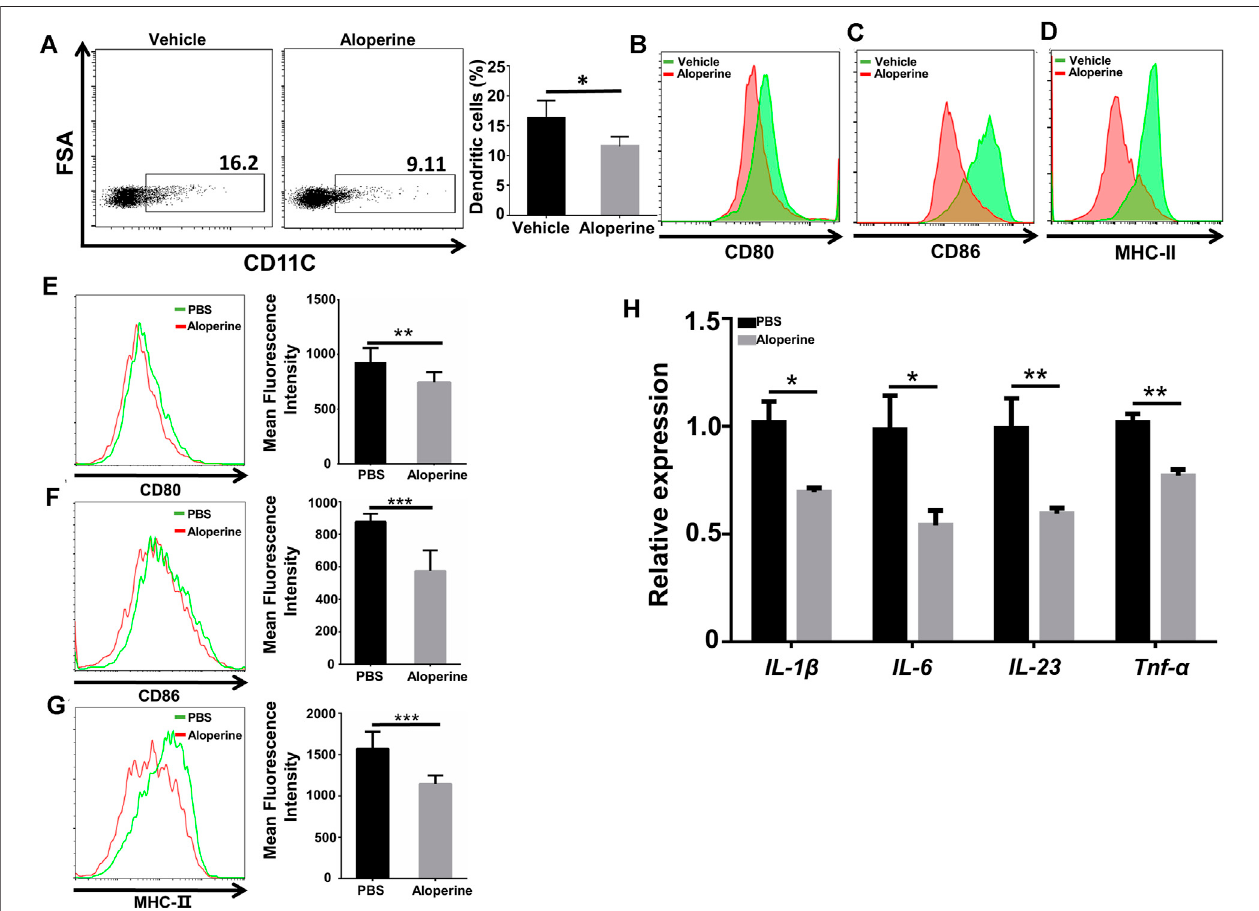
FIGURE 2 | Aloperine inhibits the activation of DCs. (A) The proportion of CD11C + DCs among CD45 + cells in the skin lesion. (B – D) Mean Fluorescence Intensity (MFI) analysis of the expression of CD80, CD86, and MHC- Ⅱ on skin DCs. (E – G) MFI analysis of the expression of CD80, CD86, and MHC- Ⅱ in in vitro differentiated BMDCs. (H) Real-time PCR analysis of cytokine expression (IL-1 β , IL-6, IL-23, and TNF- α ) in DCs. The data are shown as the mean ± SEM from three independent experiments. p p < 0.05; pp p < 0.01; and ppp p <